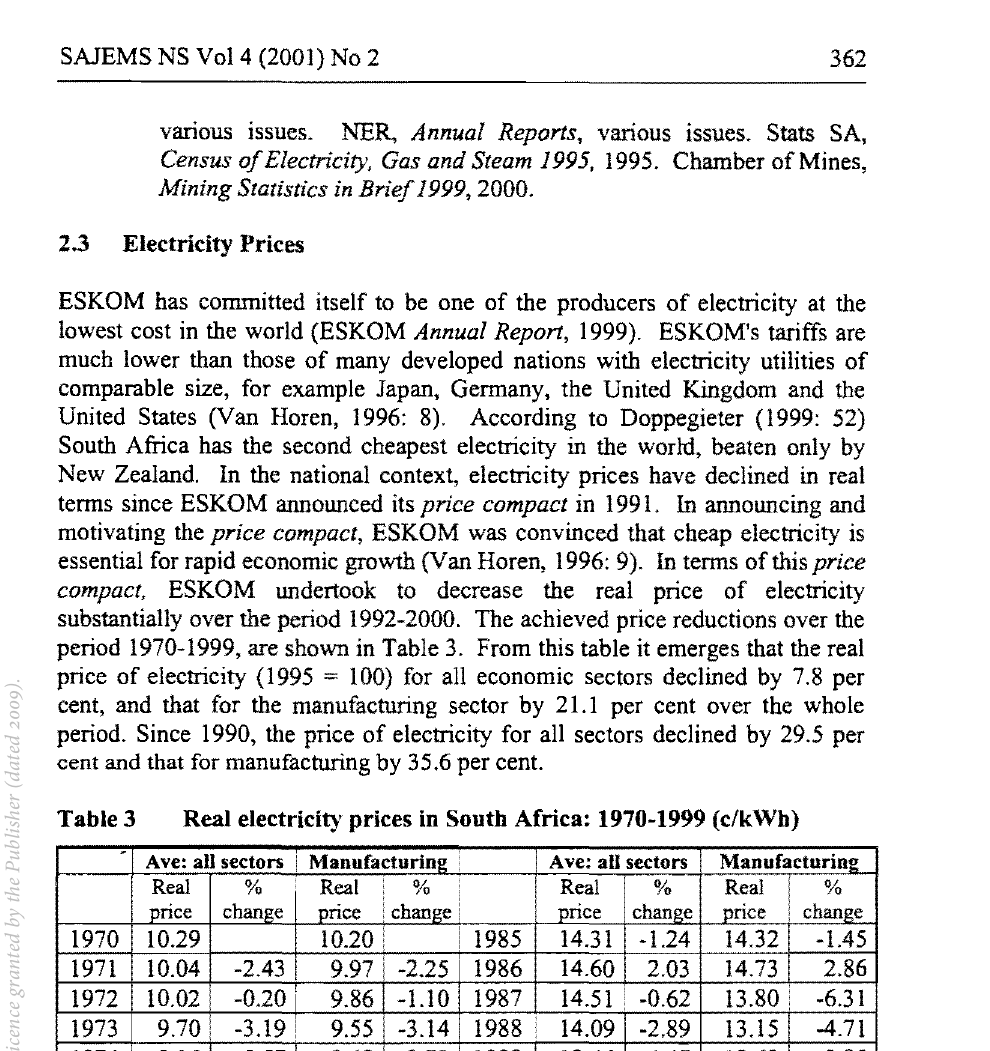
Real electricity prices in South Africa: 1970-1999